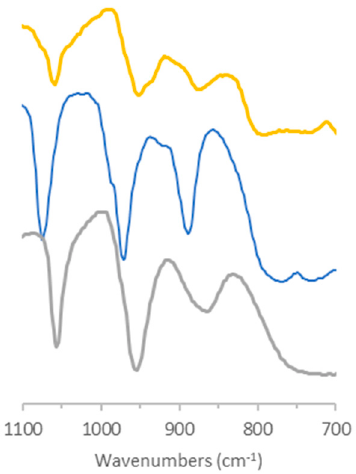
Figure 1. Infrared (IR) spectra of the zone of POM vibrations for the commercial H 3 PMo 12 O 40 precursor (grey), C 6 -Mo molecular catalyst (blue) and MR 12 -Mo grafted catalyst (orange). • 31 P Nuclear Magnetic Resonance (NMR) Spectroscopy The 31 P NMR spectra of C 4 -Mo and C 6 -Mo salts in the solution exhibit a characteristic peak at − 4.15 ppm, while those of C 4 -W and C 6 -W salts show a peak at − 15.5 ppm, in accordance with the literature data [64,65]. In the solid-state 31 P NMR spectrum of the Mo-grafted catalysts (Figure 2), the resonance is shifted to − 3.5 ppm in case of MR 4 -Mo , while two resonances at − 1.9 and − 3.5 ppm are observed for MR 12 -Mo . Likewise, in the case of the W catalysts (Figure 3), one resonance is observed for MR 4 -W (at − 15.1 ppm) and two for MR 12 -W (at − 12.4 and − 15.2 ppm). The similar behavior of both POMs seems to depend on the length of the imidazolium substituent and not on the quality of the Keggin POM precursor (the 31 P NMR in D 2 O of the commercial Mo and W precursors displayed only one signal at − 3.9 and − 15.3 ppm, respectively). The observed behavior indicates the presence of different cation-dependent interactions at the resin surface, the two simultaneously observed species possibly corresponding to species located in two different sites (i.e., closer to or farther from the imidazolium moiety) [66,67].